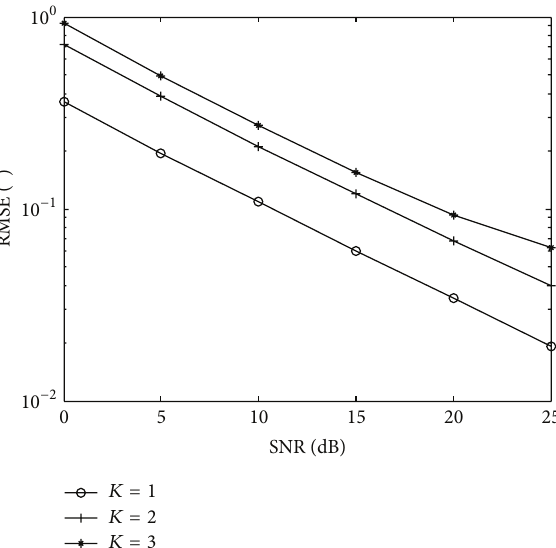
Figure 5: DOA tracking results of the proposed algorithm at SNR = 15dB (Scene 3).